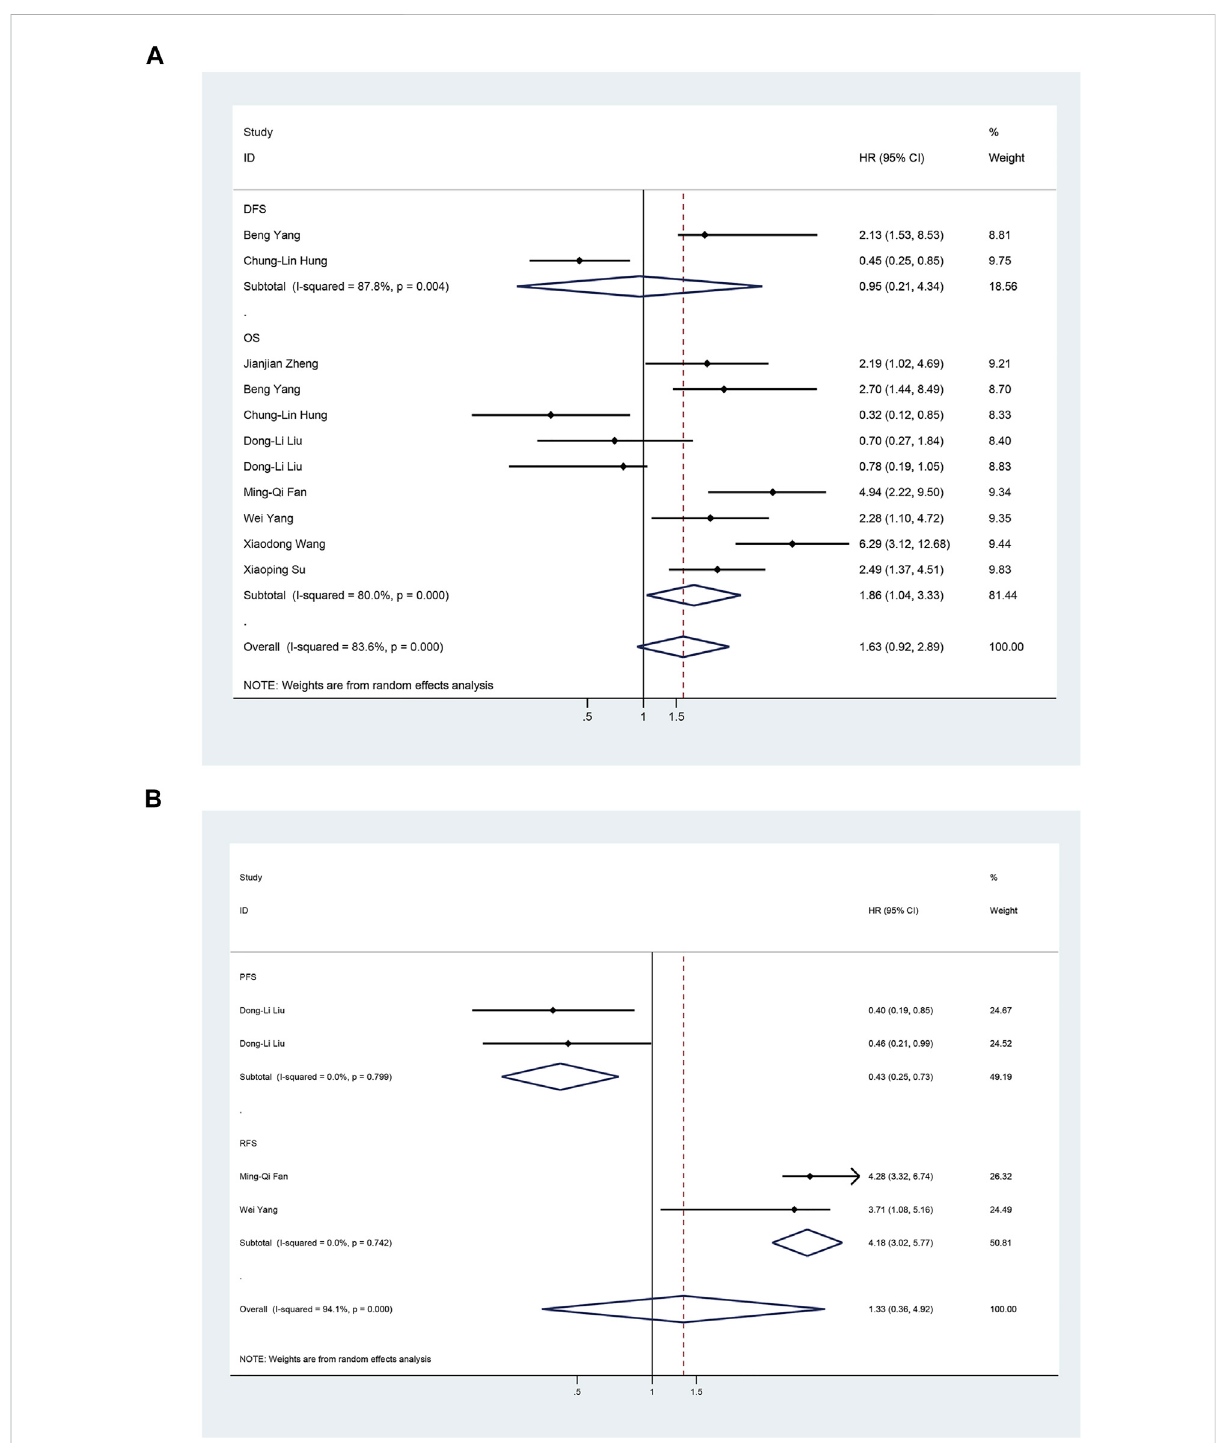
FIGURE 9 Forest plot of studies evaluating the hazard ratio of high miR-17 – 92 cluster expression in association with survival outcomes in hepatocellular carcinoma patients. (A) Studies are based on overall survival (OS) and disease-free survival (DFS); (B) Studies are based on Recurrence-Free Survival (RFS) and Progression-Free-Survival